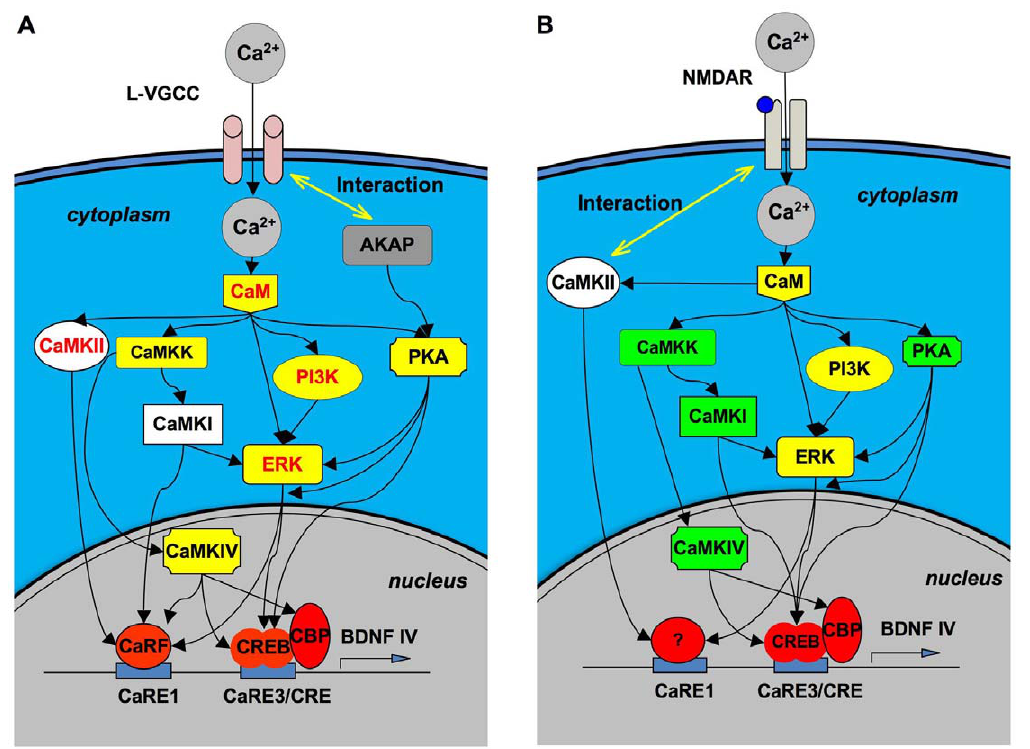
Figure 11. L-VGCC- and NMDAR-mediated activation of CaRE1 and CaRE3/CRE are differentially regulated. Depending on the route of Ca 2 + entry, different Ca 2 + -stimulated protein kinases are required for L-VGCC- (A) and NMDAR-mediated (B) transcriptional up-regulation of BDNF exon IV. The activation of the major calcium responsive elements, CaRE1 and CaRE3/CRE, also require different signaling molecules. The functional molecules in the Ca 2 + -triggered signaling cascade are connected by arrows pointing from up-stream regulators to down-stream targets. For both (A) and (B), protein kinases in the white boxes are required for CaRE1 activation. Protein kinases in the green boxes are required for CaRE3/CRE activation. Protein kinases in the yellow boxes are required for the activation of both CaRE1 and CaRE3/CRE. Therefore, the changing of box colors for a specific molecule between (A) and (B) indicates the different mechanism underlying L-VGCC- and NMDAR-mediated transcription. For (A), the signaling molecules written in red are those required for CaRF activation. Therefore, based on the color of the box and the color of the word, the regulatory difference between CaRE1 and CaRF could be discriminated. For (B), the ‘‘?’’ indicates that the transcription factors need to be identified for NMDAR- mediated CaRE1